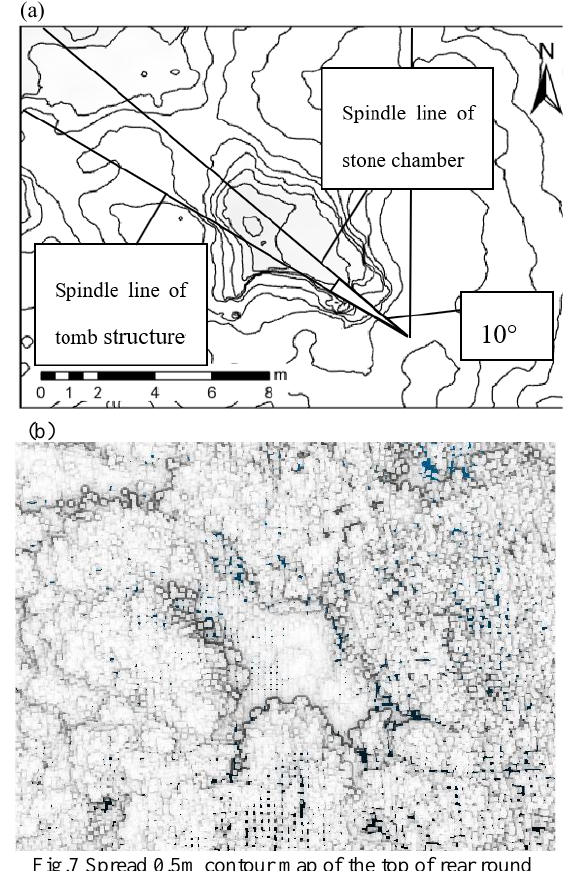
Fig.7 Spread 0.5m contour map of the top of rear round part. The crossing angle is 10°.(vs. square part) And Point cloud data map of stone chamber structure seen from above.